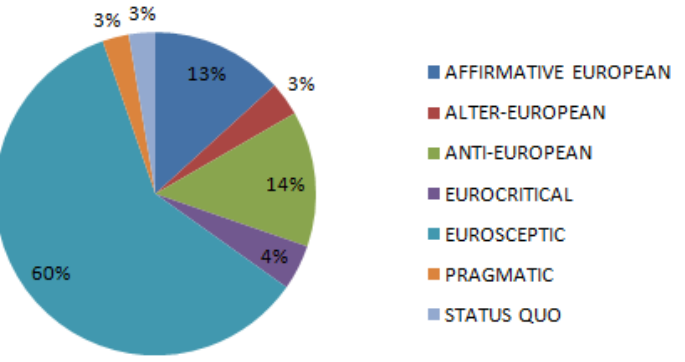
Figure 9. EU polity evaluations (n = 264).